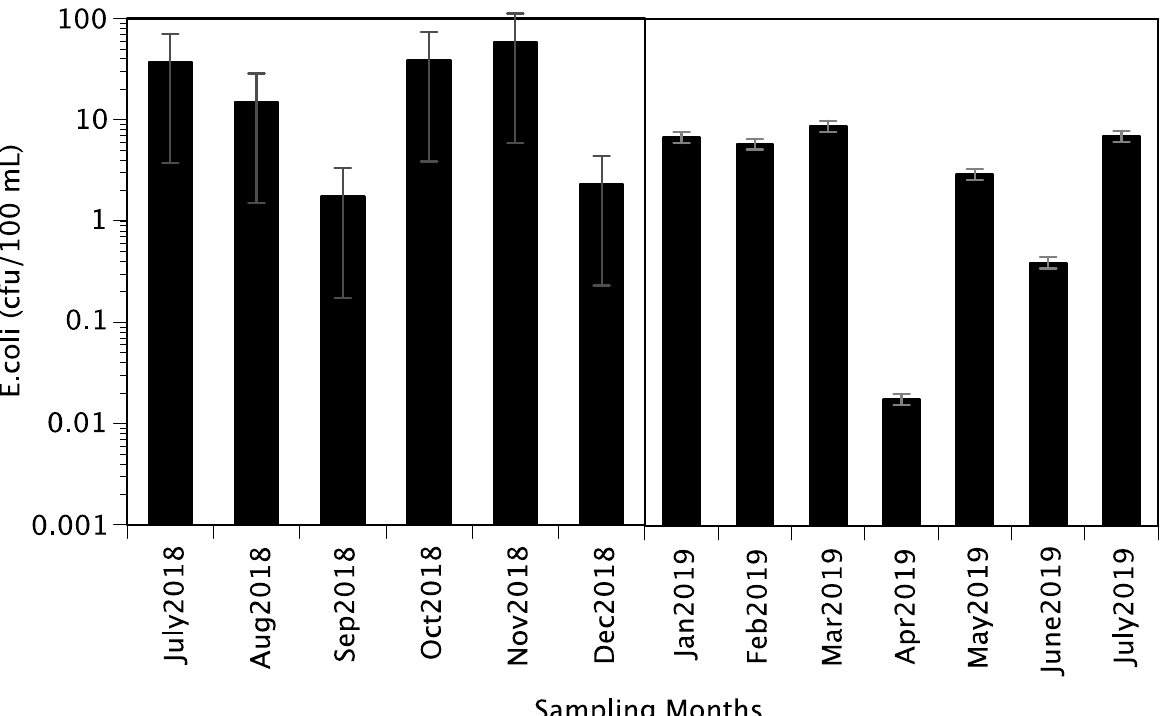
Figure 3. Average values of total coliform of raw water (n = 390).